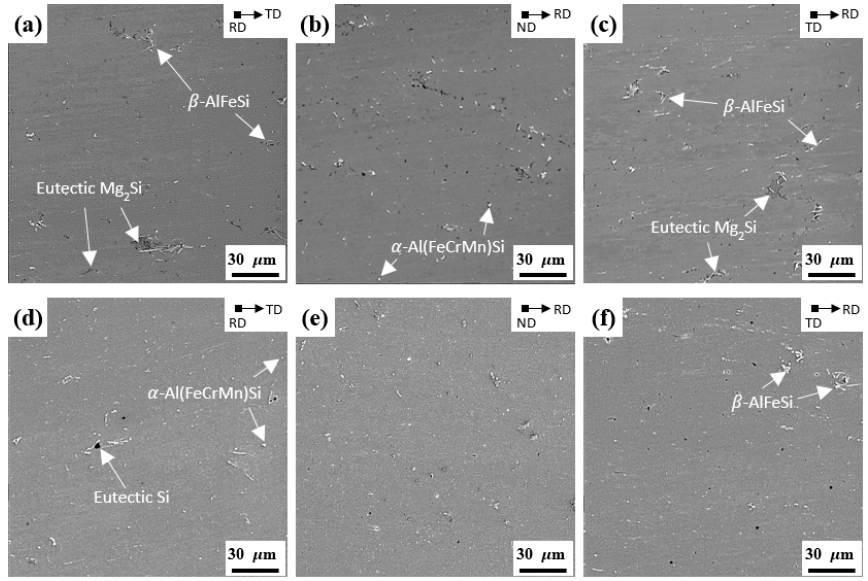
Figure 4. SEM images of ( a – c ) RH and ( d – f ) RL alloys with a thickness of 5.6 mm before cold rolling: ( a , d ) RD, ( b , e ) ND, and ( c , f ) Figure 5a shows the size distribution of the microscale particles before cold rolling.